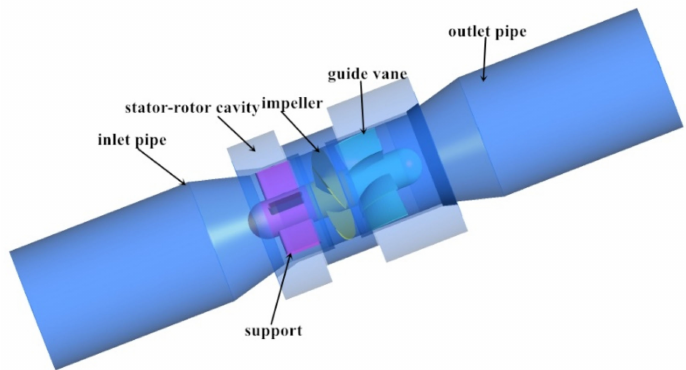
Figure 1. Three-dimensional calculation model of the full tubular pump.